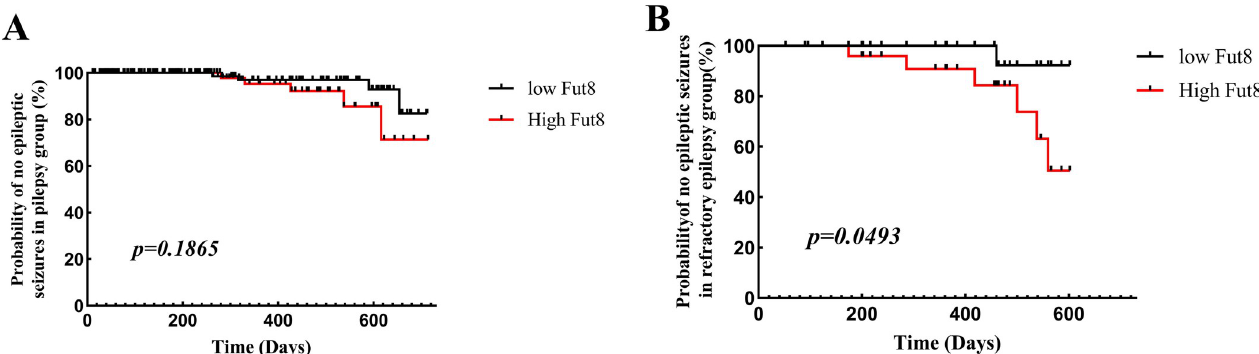
Fig 5. Kaplan–Meier curve illustrating incidence of epileptic seizures of patients during the follow-up period, based on Fut8 expression. A . The incidence of epileptic seizures in epilepsy patients within 2 years between high and low Fut8 expression. B . The incidence of epileptic seizures in refractory epilepsy patients within 2 years between high and low Fut8